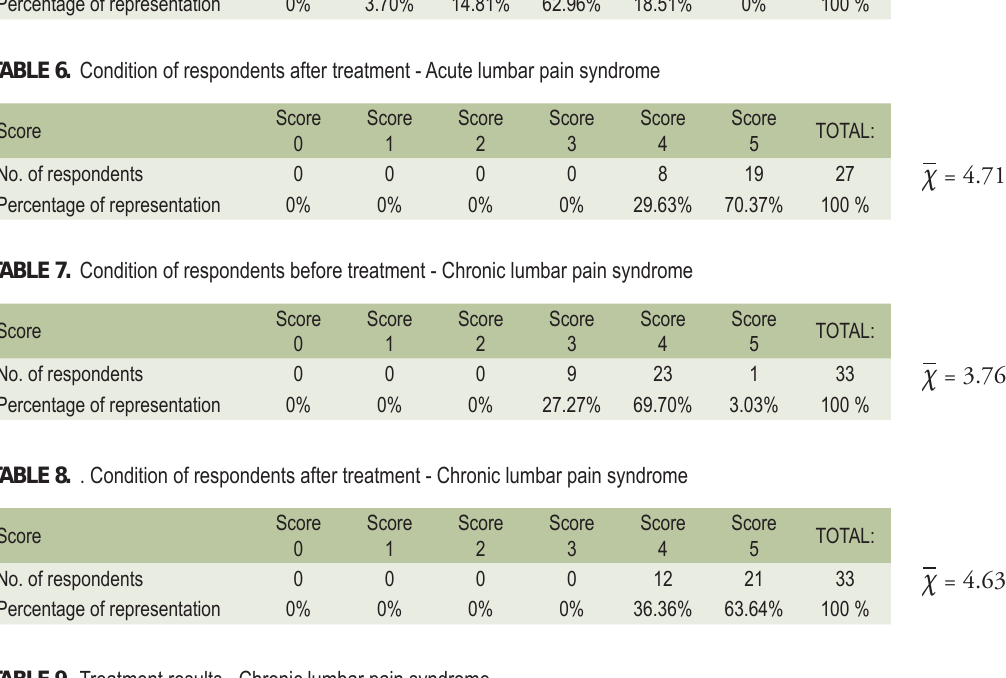
TABLE 9. Treatment results - Chronic lumbar pain